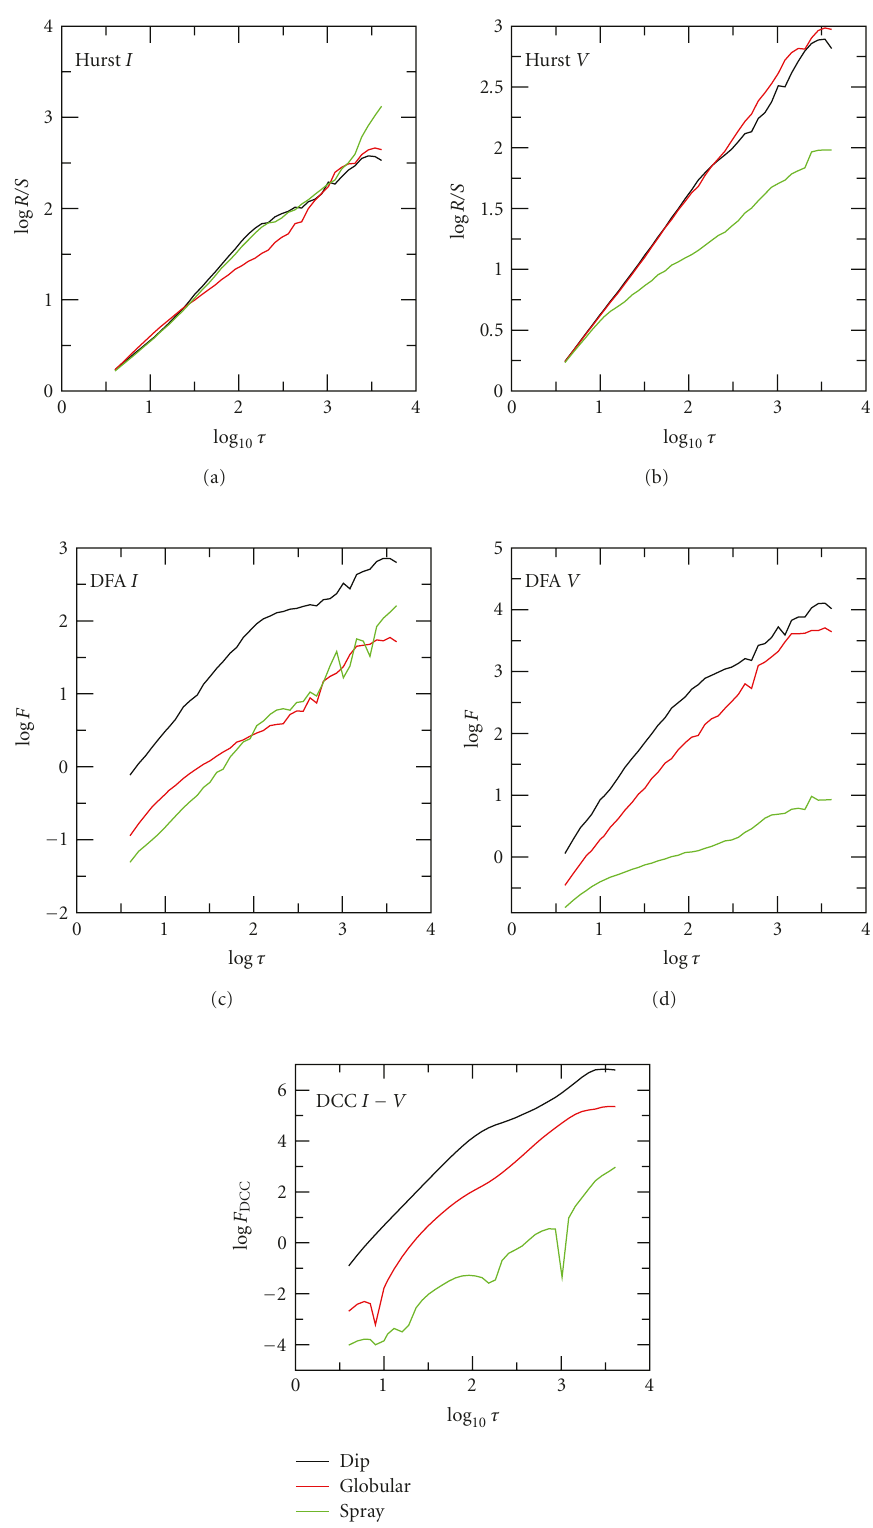
Figure 5: Examples of curves obtained from Hurst (top), detrended-fluctuation (center), and detrended-cross-correlation (bottom) analyses to current ( I ) and voltage ( V ) sample signals obtained under dip (top), globular (center), and spray (bottom) metal-transfer modes. Logarithms are in base 10, and the time window size is measured in tenths of a